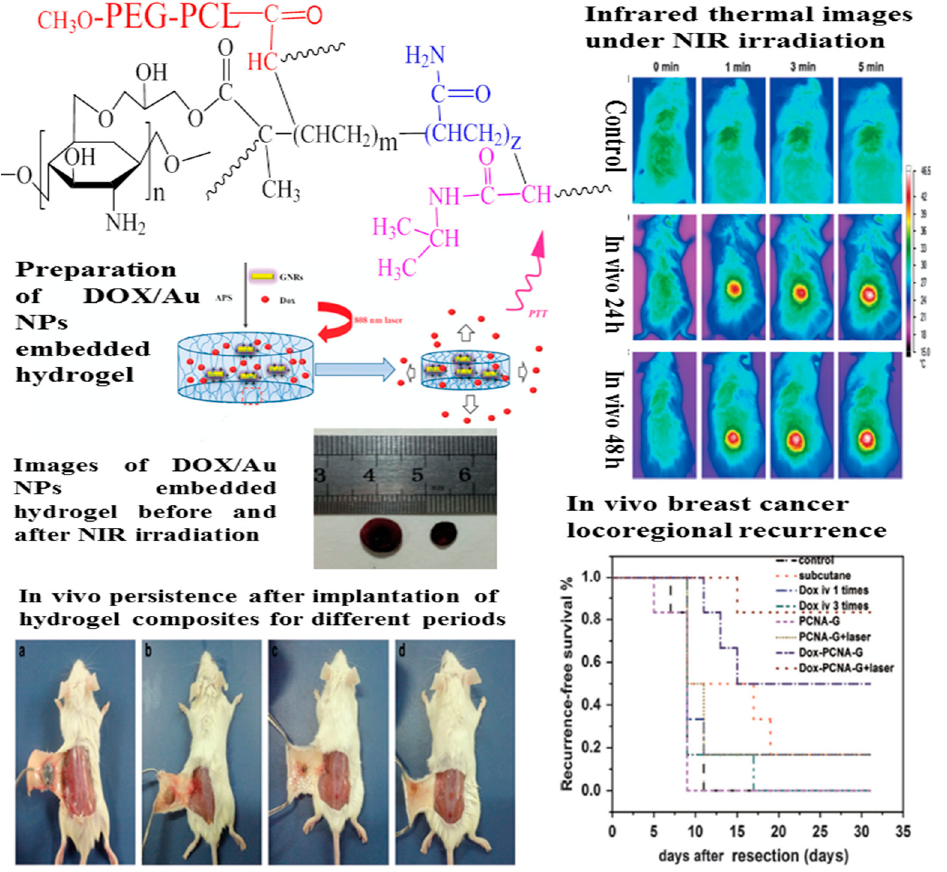
Figure 9. Schematic illustration of Doxorubicin (DOX)/Au NPs embedded hybrid hydrogels with the ability of photothermal therapy (PTT) and near infrared (NIR)-triggered thermo-responsive drug release, reproduced with permission from [270]. Copyright Nature Publishing Group,